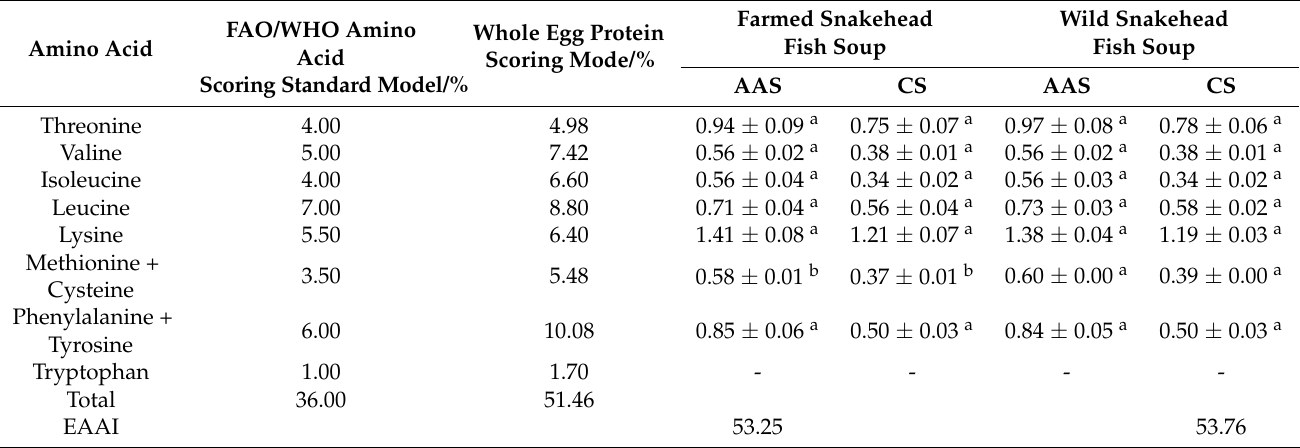
Table 3. Scoring AAS, CS and EAAI of protein in soup made from farmed and wild snakehead